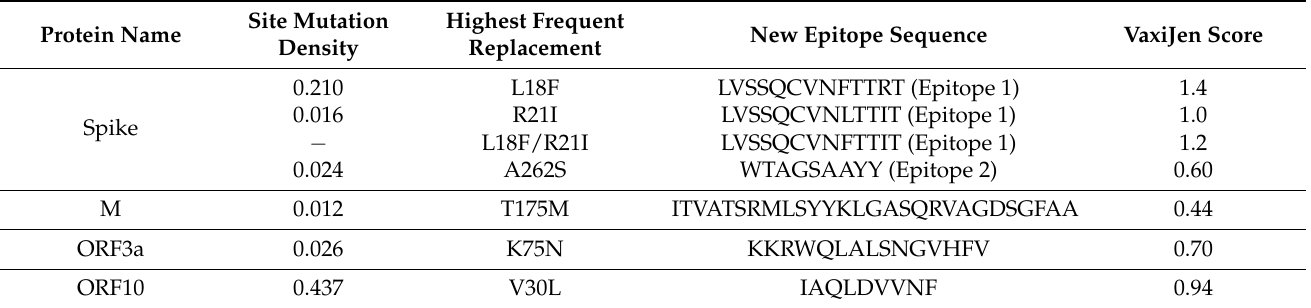
Table 5. Epitopes selected for reanalysis with their respective site mutation densities and the highest frequent replacement. New sequences of epitopes are listed with their antigenicity scores (Bold and underlined sequences denote replaced residues). Protein